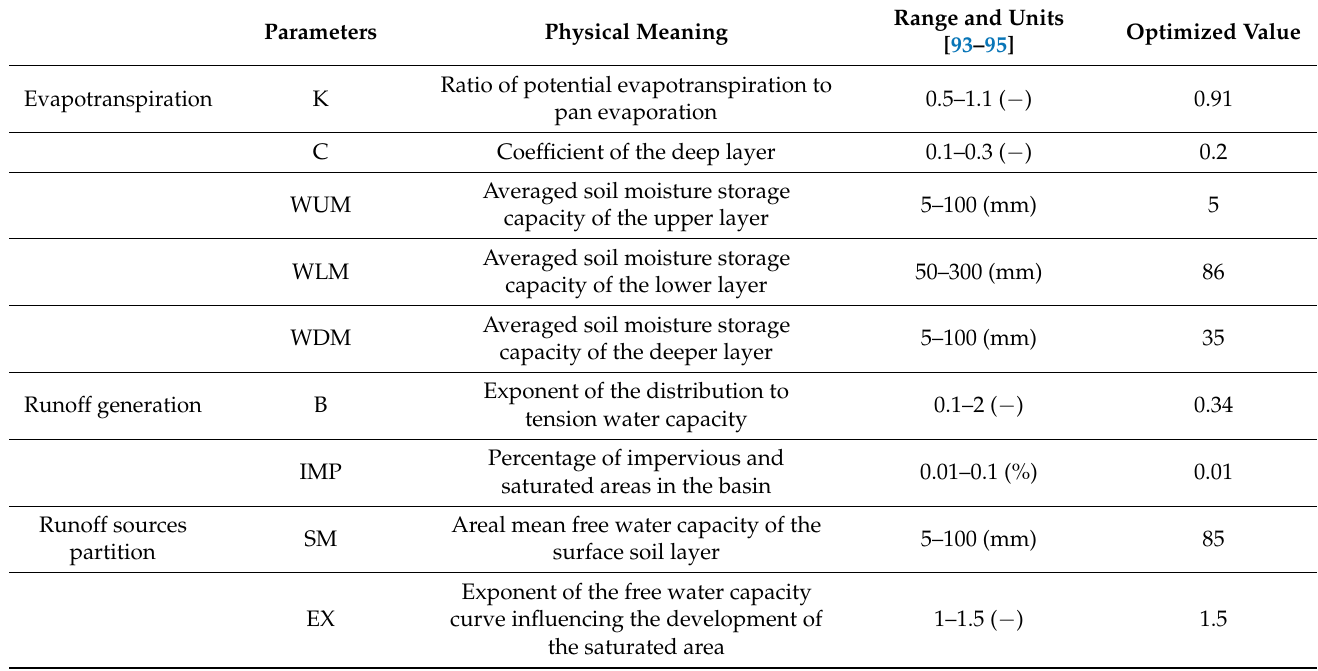
Table 3. The parameters of the XAJ